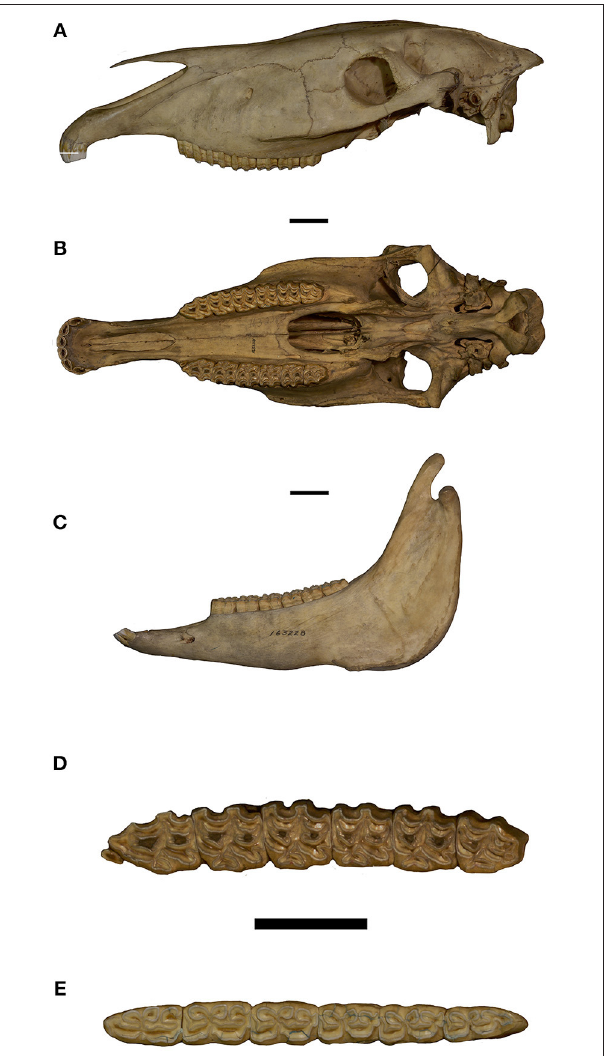
FIGURE 11 | Equus grevyi . (A) Skull in lateral view; (B) Skull in ventral view; (C) Mandible in lateral view; (D) Upper tooth row in occlusal view; (E) Lower tooth row in occlusal